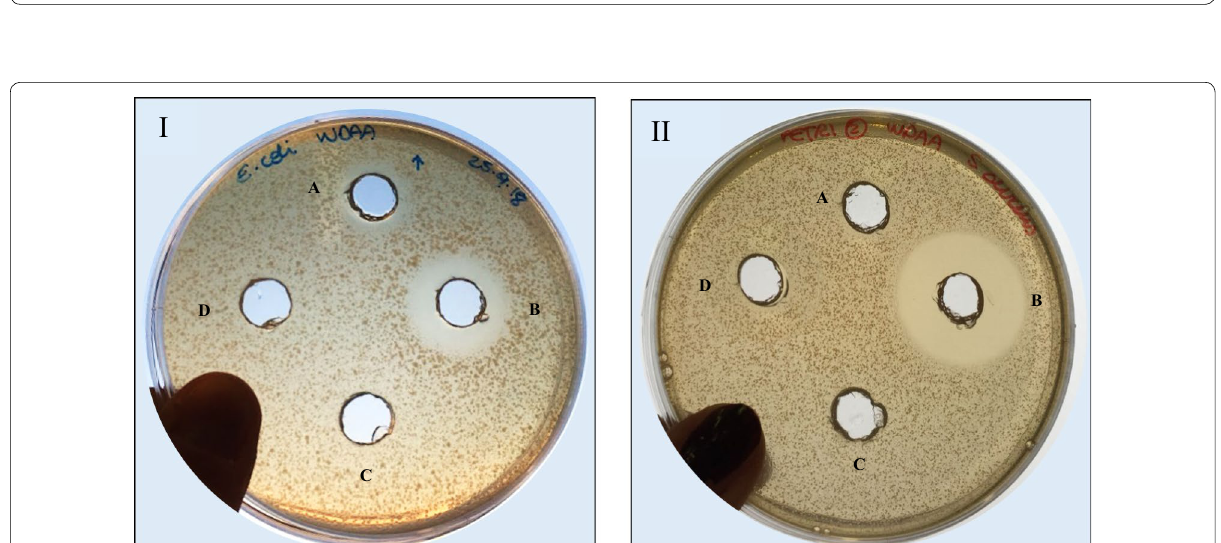
Fig. 5 Antimicrobial spectrum activity of plantaricin P1053. The antimicrobial spectrum activity of the plantaricin P1053 was verified through the inhibition growth halo in the agar well diffusion assay. The first panel shows the inhibition haloes against E. coli ATCC 25922 and the second panel against S. aureus ATCC 6538 produced by the plantaricin P1053 at neutral pH (A), by the plantaricin P1053 at pH 2 (B), by the NaCl 0.1 M at pH 2 (C) and by NaCl 0.1 M at pH 6.5 (D) as negative